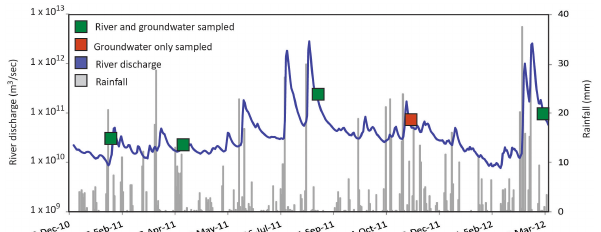
Figure 2. Surface and groundwater sampling frequency super- imposed on Tambo River hydrograph (Battens Landing,